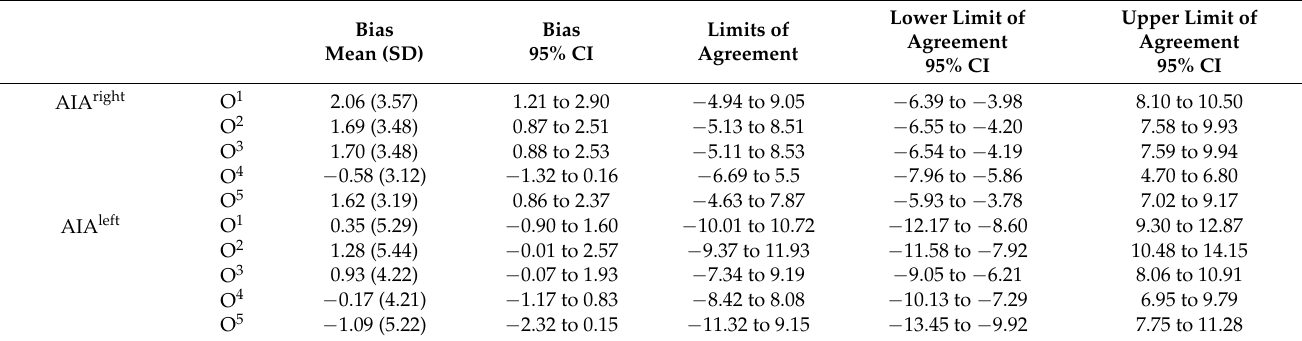
Table 4. Acetabular index angle. Bland Altman limits of agreement and bias (mean and SD). Agreement between algorithm and individual human readers. (n = 71).